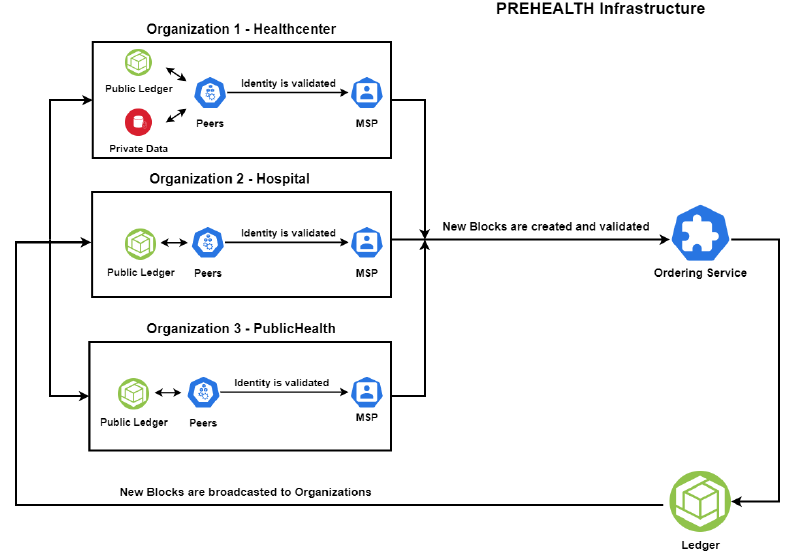
Figure 3. PREHEALTH